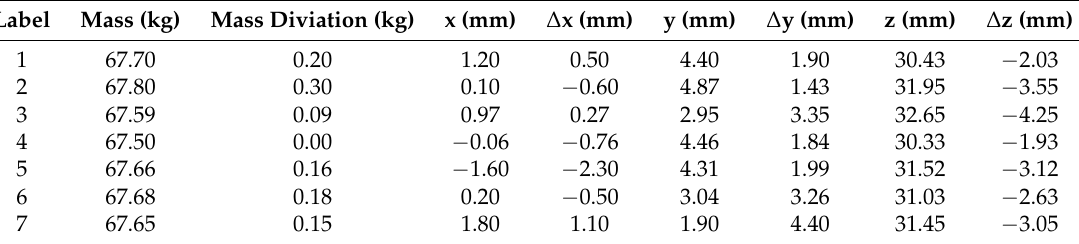
Figure 11. Mock-up of joints after mass-matching. Table 6. Mass and barycenter of the